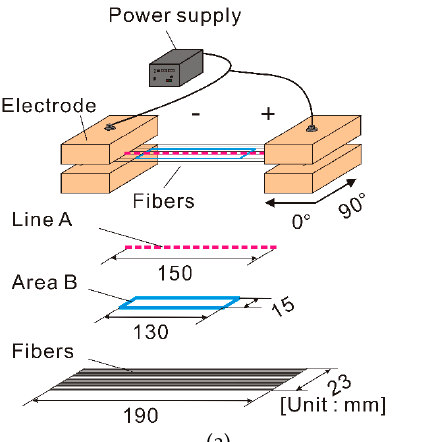
Figure 2. Schematic drawing and photo image for experimental setup of the temperature distribution measurement of each fiber. ( a ) Schematic drawing. ( b ) Photo image.